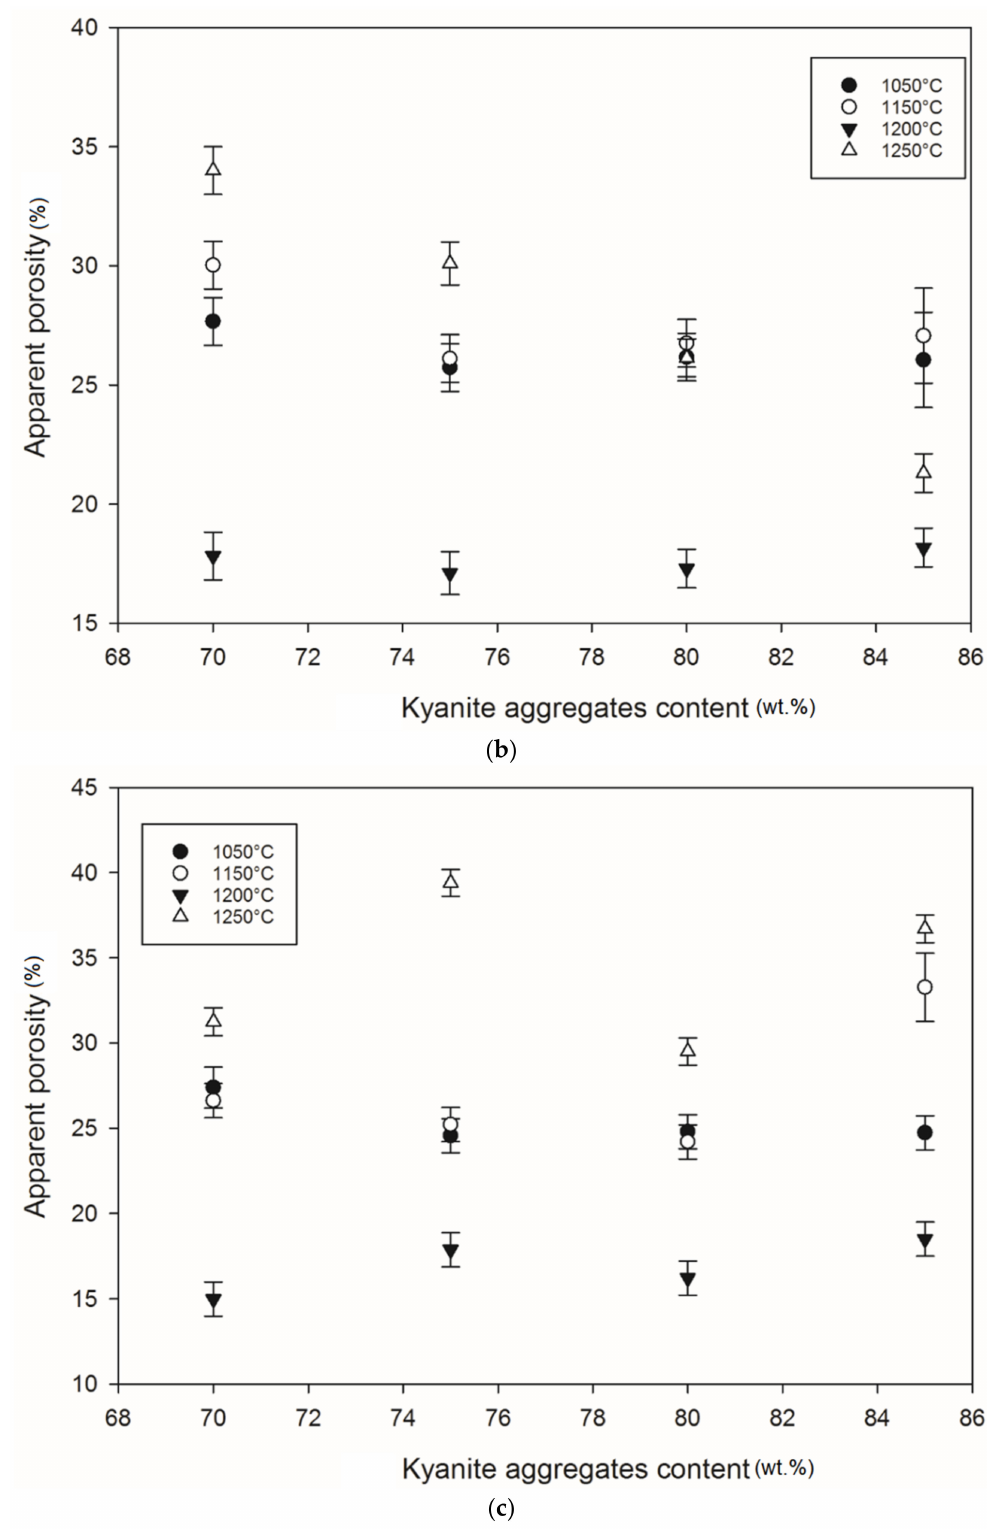
Figure 13. Apparent porosity trend: ( a ) RB series, ( b ) RC series and ( c ) RD series. At 1250 ◦ C, the release of additional mullite and cristobalite from the decomposition of kyanite aggregates seemed to create a volumetric expansion and developed conditions for limited contact among the grains, thereby also favoring an increase in the porosity and voids within the matrices. This made the resulting matrices less dense, with high levels